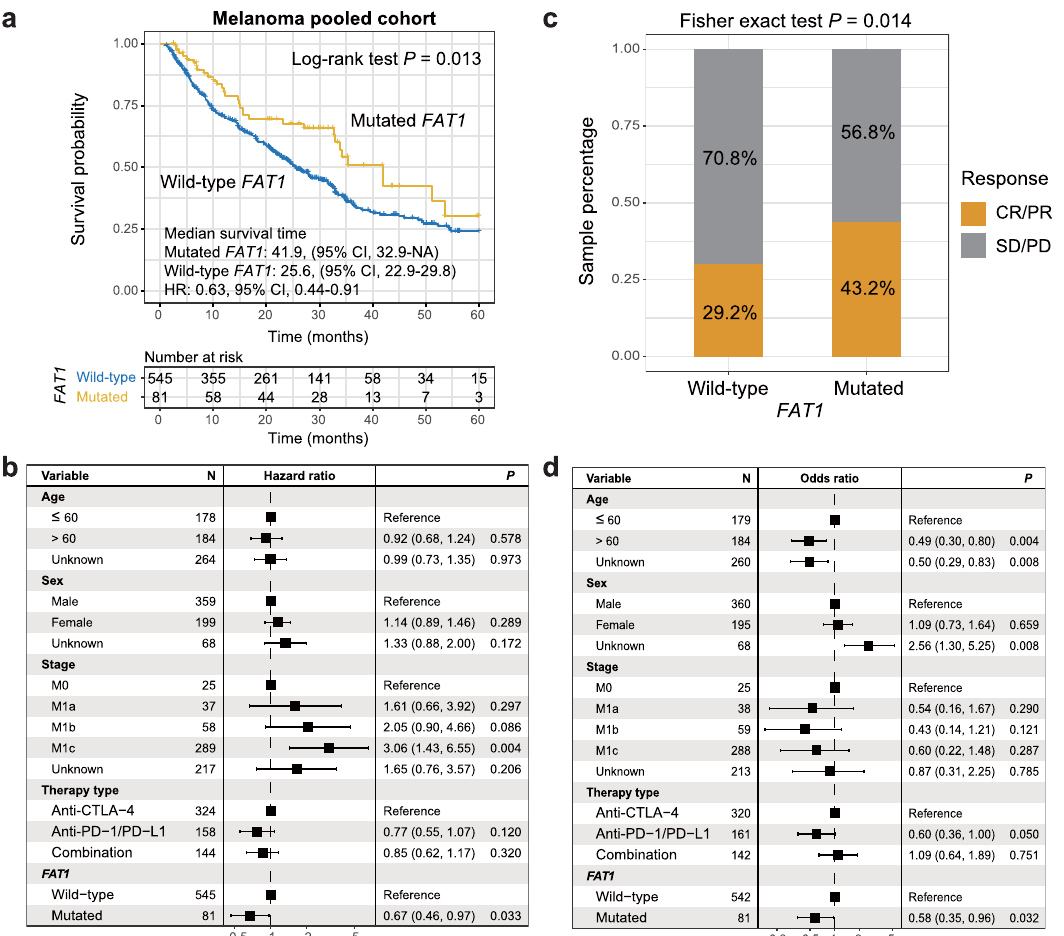
Fig. 2 Association of FAT1 mutations with ICI prognosis and response in melanoma cohort. a Kaplan – Meier survival curves strati fi ed by FAT1 mutational status. b Multivariate Cox regression model between FAT1 mutations and ICI outcome with age, sex, stage, and therapy type taken into account. Black box: hazard ratio; black scale bar, 95% con fi dence interval of hazard ratio. c Distinct ICI response rates in FAT1 mutated and wild-type subgroups. d Multivariate logistic regression model between FAT1 mutations and ICI response with age, sex, stage, and therapy type taken into